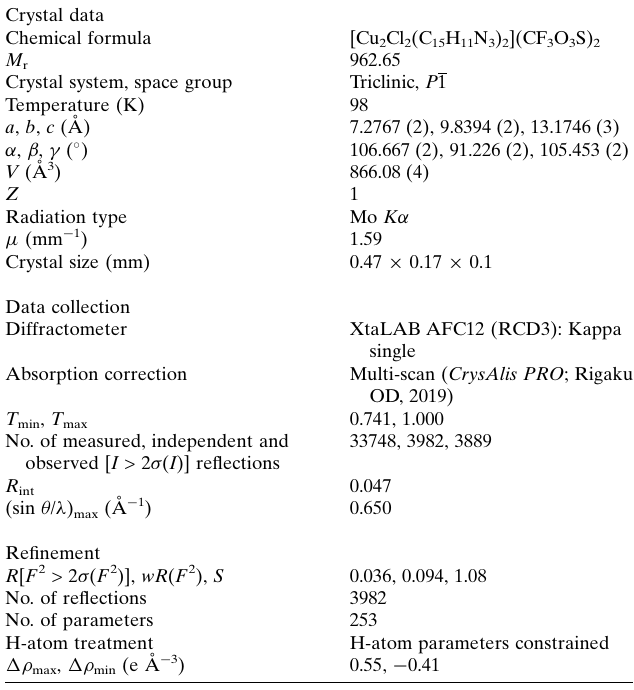
Table 2 Experimental details. Crystal data Chemical formula